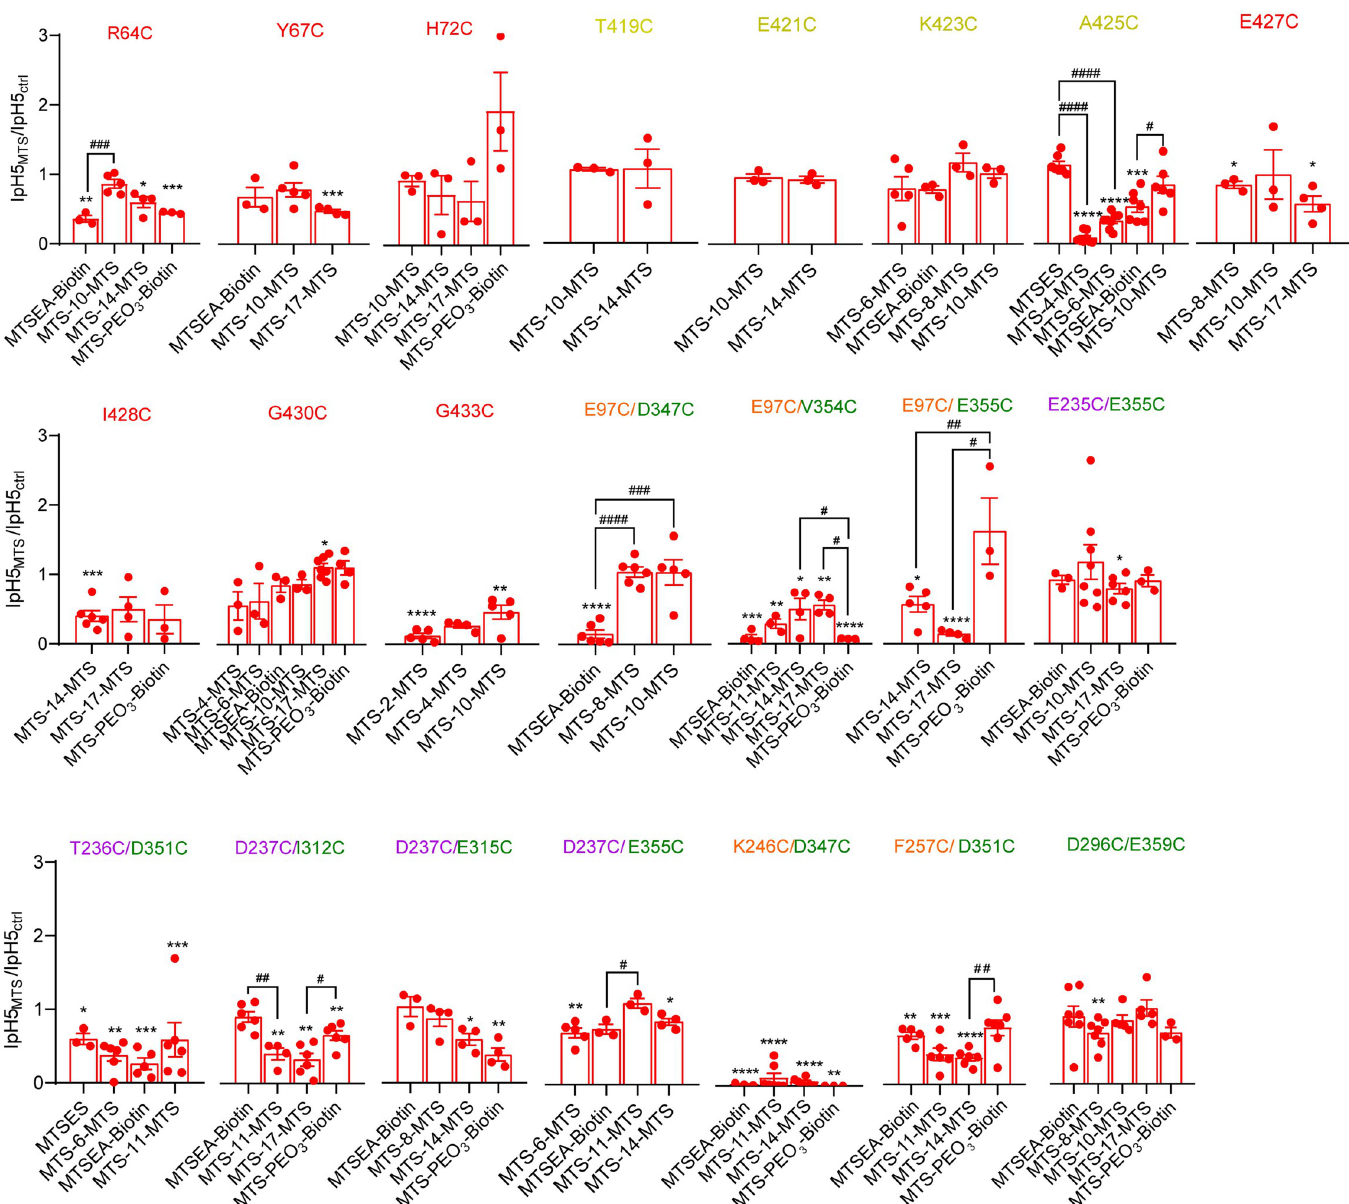
Fig 9. Changes in maximal peak current amplitude induced by MTS reagents. IpH5 MTS /IpH5 Ctrl ratios plotted here were determined in the experiments described in Figs 7 and 8. Differences between the control and the MTS condition are indicated as � , p < 0.05; �� , p < 0.01, ��� , p < 0.001 and ���� , p < 0.0001 (paired t-test), and between cross-linkers and matching monovalent MTS reagents as #, p < 0.05; ##, p < 0.01, ###, p < 0.001 and ####, p < 0.0001 (Ordinary One-way ANOVA and Tukey post-hoc test). The color of the mutant label matches that of the domain in which the mutation is